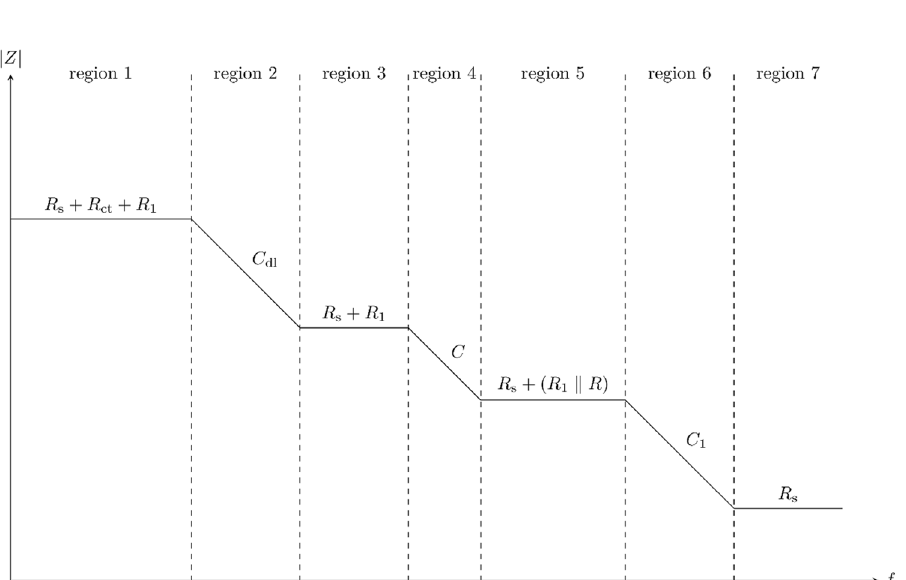
Figure 2. A schematic drawing based on the asymptote-based approximation of the impedance spectra of the simplified unified equivalent circuit model for cell